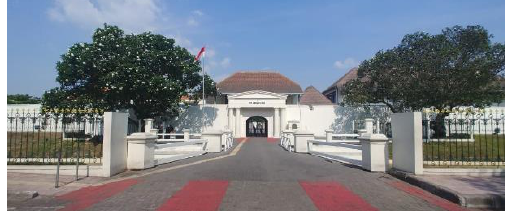
Figure 3. Vredeburg Fort Museum Building